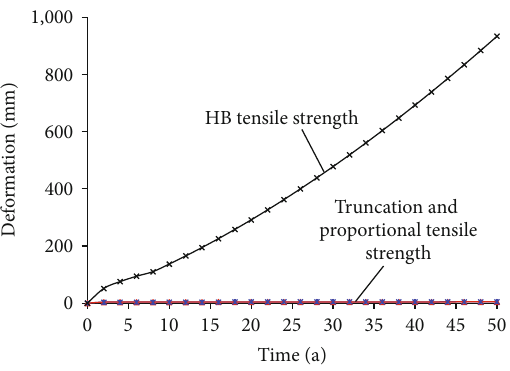
Figure 15: Deformation process of measuring point